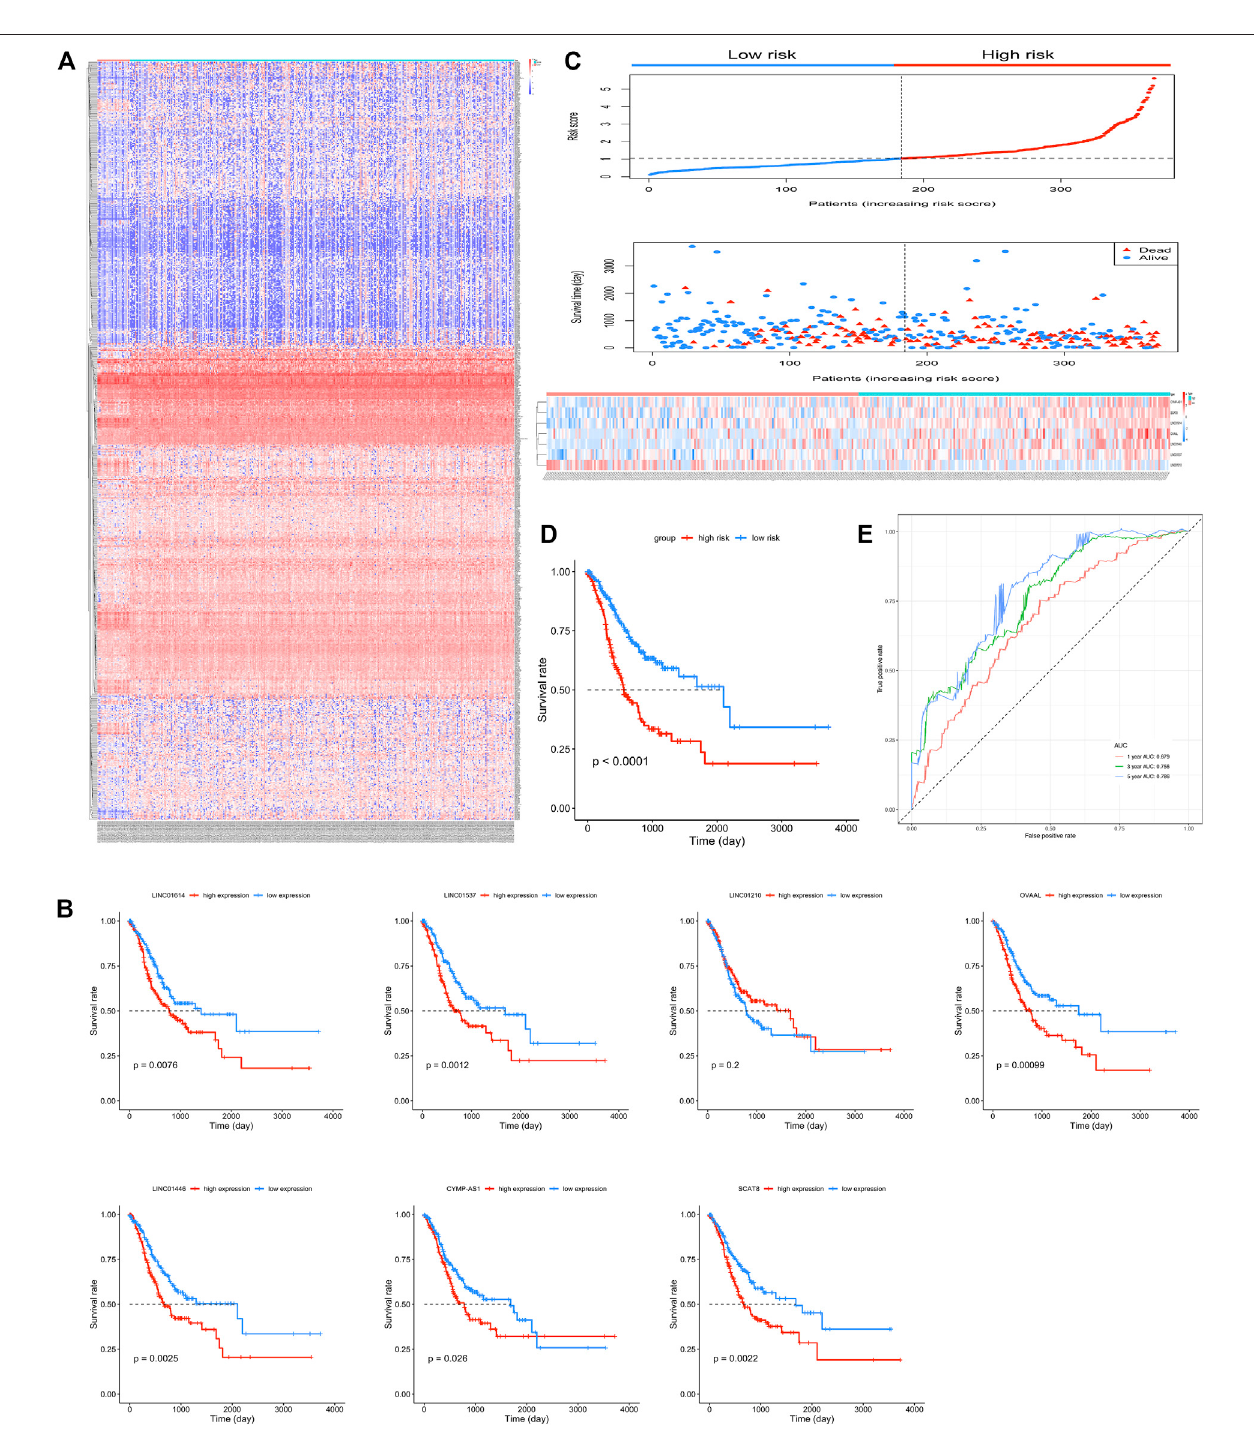
FIGURE1| Sevencandidatelongnon-codingRNAs(lncRNAs) ofgastriccancer(GC). (A) Heatmap ofthe858differentiallyexpressed lncRNAsinGCpatients. (B) Kaplan-Meier survival curves of overall survival (OS) based on LINC01614 , LINC01537 , LINC01210 , OVAAL , LINC01446 , CYMP-AS1 , and SCAT8 , respectively, in GC patients. (C) Risk score and patients ’ survival status distribution and expression illustrated using a heatmap of seven lncRNAs in high- and low-risk groups. (D) Kaplan- Meier survival curves for OS in GC patients based on the seven-lncRNA signature. (E) Receiver operating characteristic curve analysis of the seven-lncRNA signature for OS in GC